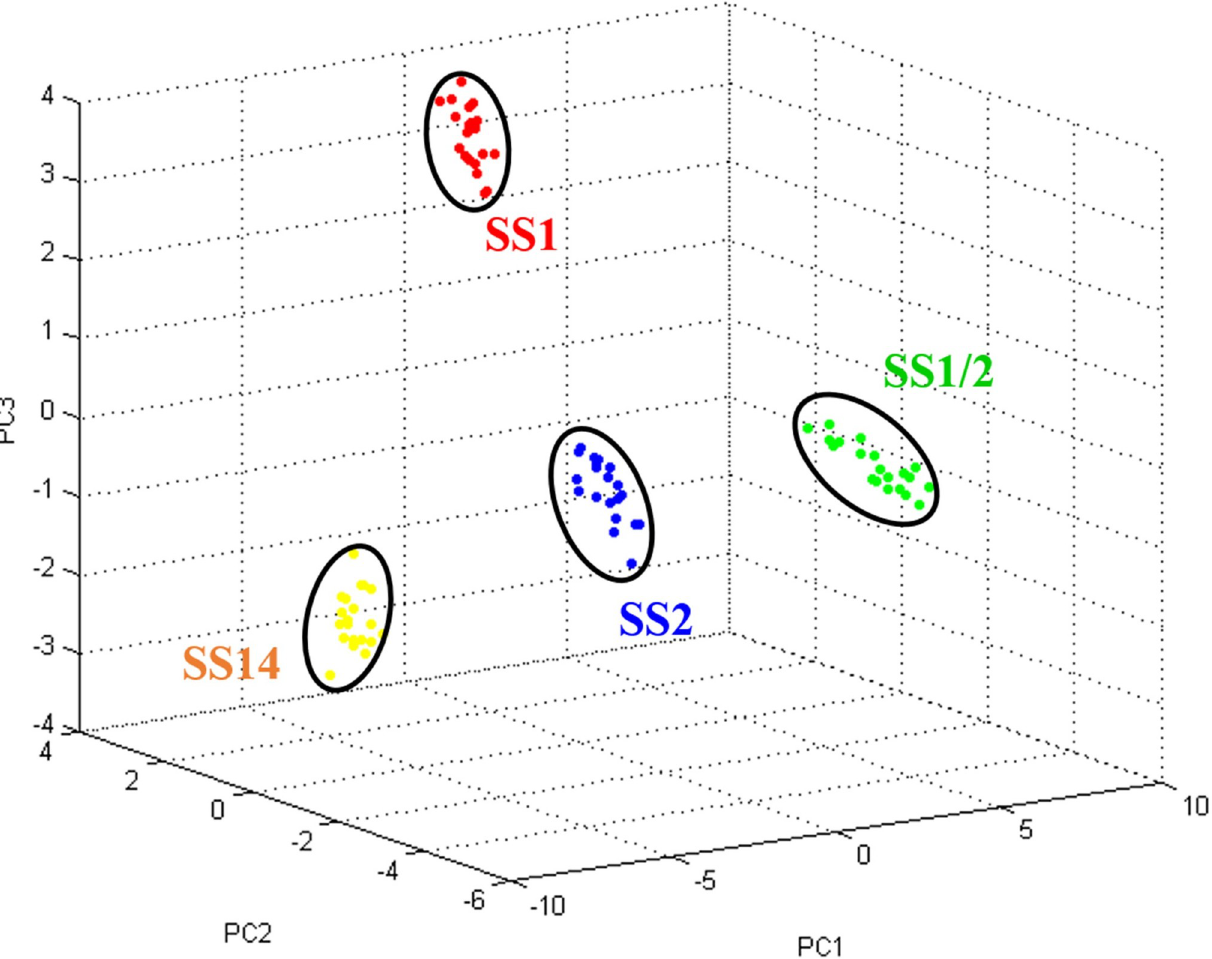
Fig 3. The PCA, based on the PMFs, of the ambiguous serotypes of S.suis SS2, SS1/2, SS1, and SS14. SS1, SS2, SS1/2, SS1, and SS14 represent the clusters of S. suis SS2, SS1/2, SS1, and SS14.